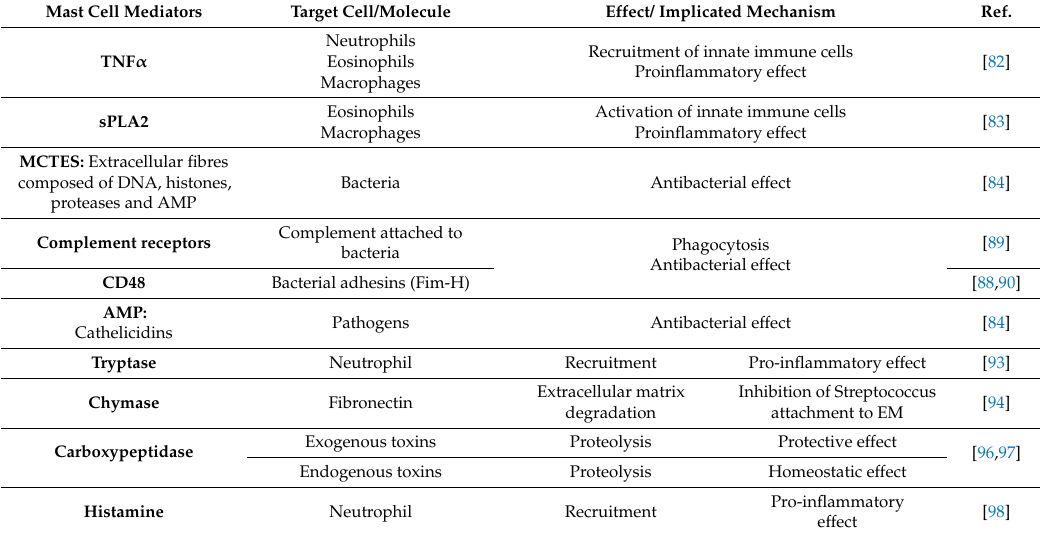
Table 3. Mast cell implication in innate